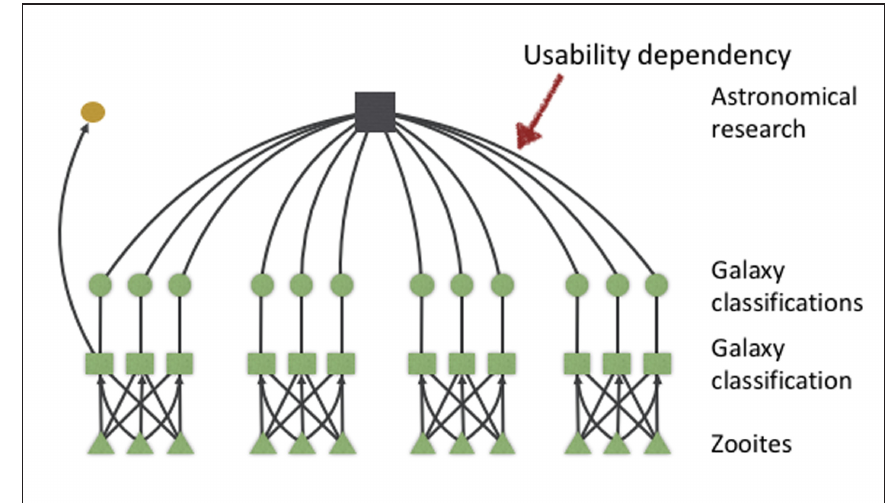
Figure 3: Flow of data in the Galaxy Zoo